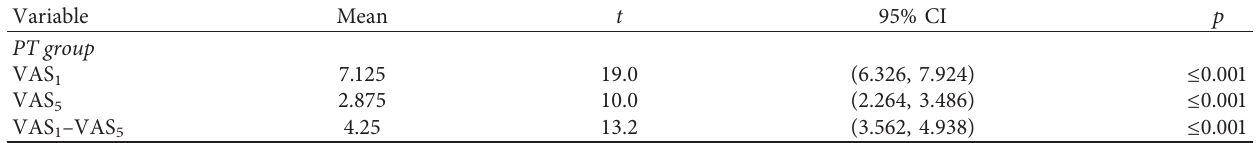
Table 2: Significance of mean differences in pain intensity for the PT group.